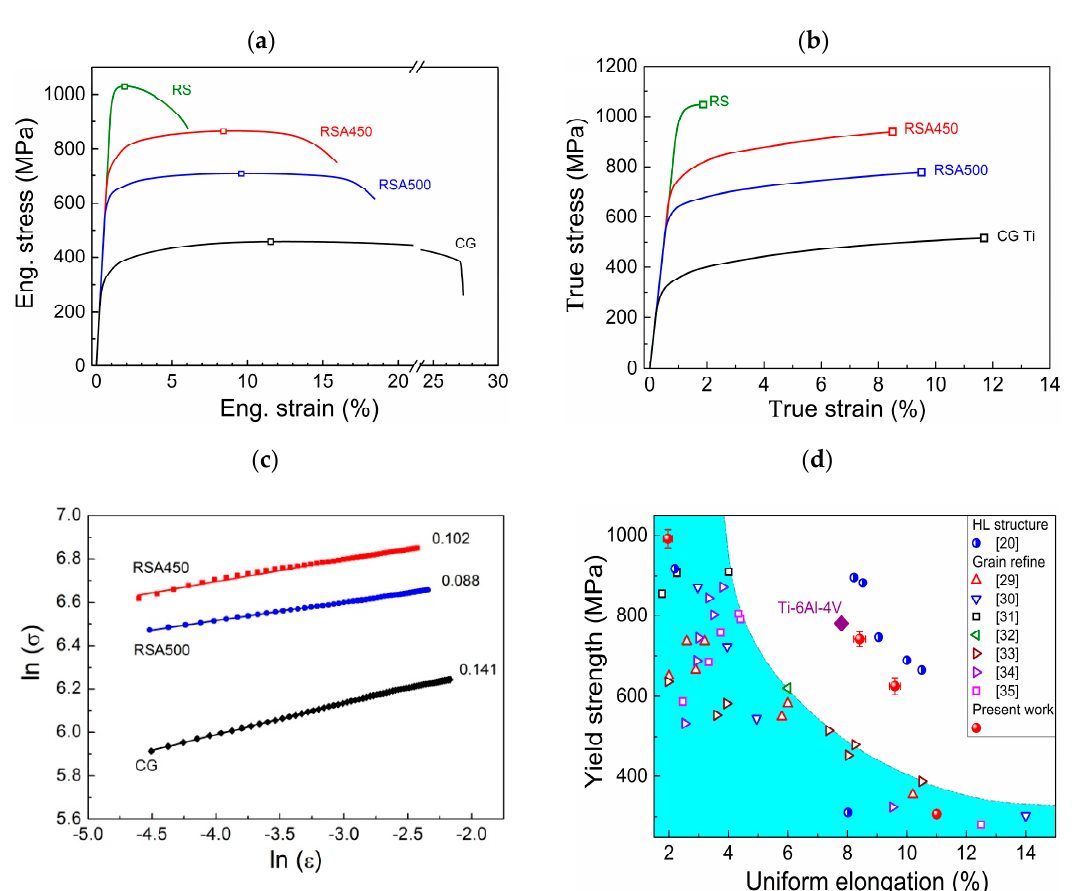
Figure 1. Tensile behaviors of CP-Ti processed by RS and annealing treatment: ( a ) typical tensile curves, ( b ) true stress-strain curves, ( c ) plot of ln( σ ) - ln( ε ) for indexing strain hardening exponent in the Hollomon equation ( σ = k ε n ), ( d ) Excellent strength-ductility synergy of current CP-Ti compared with other experimental results. Table 1. Mechanical properties of present RS-processed samples and Ti-6Al-4V alloy.